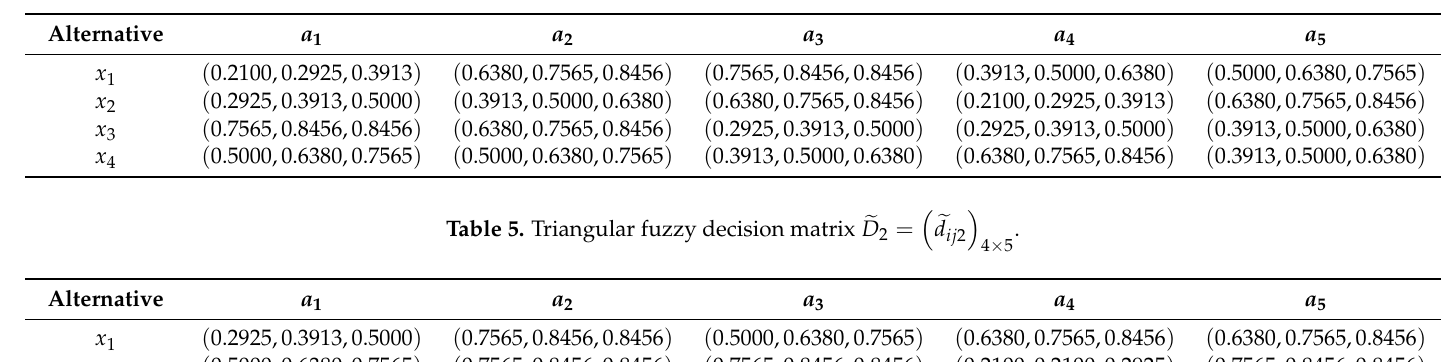
(cid:16) (cid:17) . (cid:101) d ij 1 4 × 5